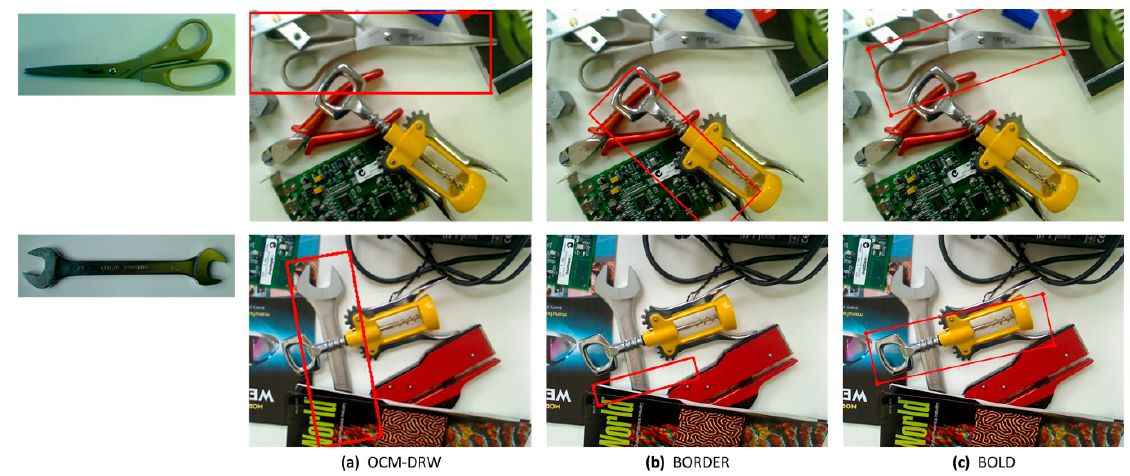
Figure 11. Recognition results from D-Textureless dataset based on OCM-DRW, BORDER and BOLD. ( a ) OCM-DRW successfully detects; ( b ) BORDER fails to detect; ( c ) BOLD also fails to detect.